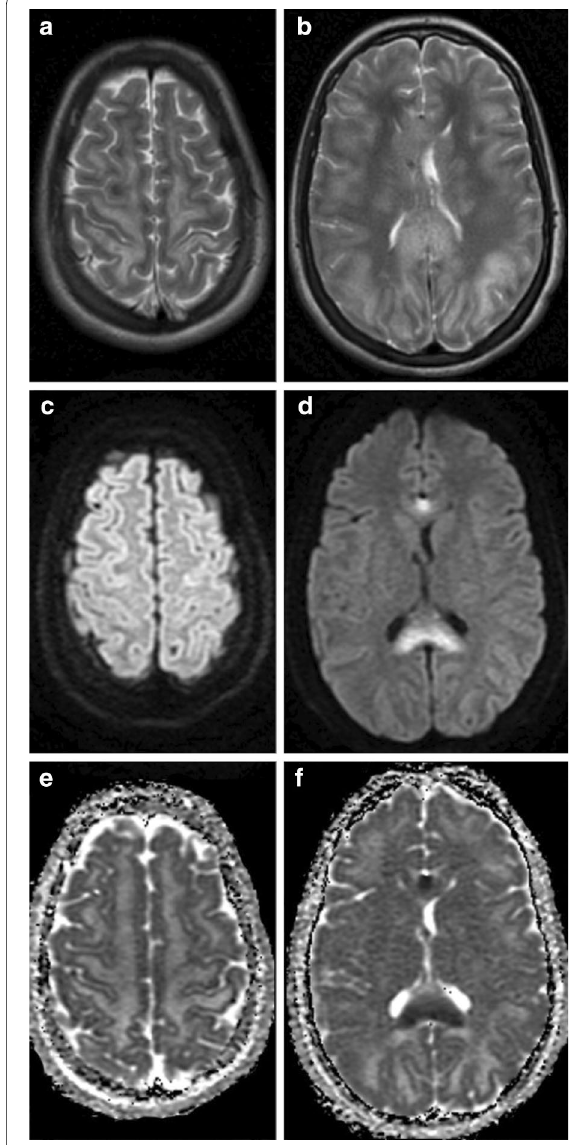
Fig. 3 A case representing the various patterns of diffusion abnormalities seen in CFE. T2 ( a , b ), DWI ( c , d ), and ADC ( e , f ) MRI images at the level of the centrum semiovale (left column), and at the level of the basal ganglia (right column) of a 16-year-old polytraumatised female patient acquired on day 12 after hospital admission. T2 weighted images show hyperintense signal in the subcortical white mater, internal capsule and the corpus callosum ( a , b ). Diffusion-weighted MR Image with a b value of 1000 s/mm 2 ( c , d ), and ADC ( e , f ) images show cytotoxic edema affecting the corpus callosum and facilitated diffusion over the subcortical white